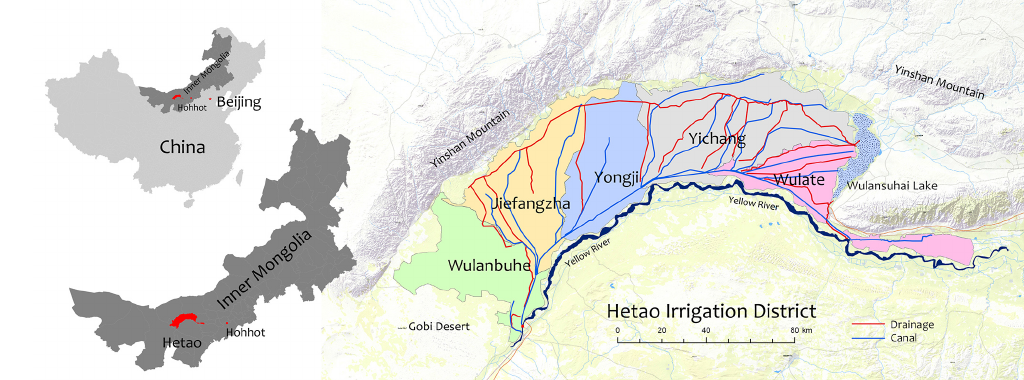
Figure 1. The Hetao Irrigation District Inner Mongolia, showing the five irrigation sub-districts.